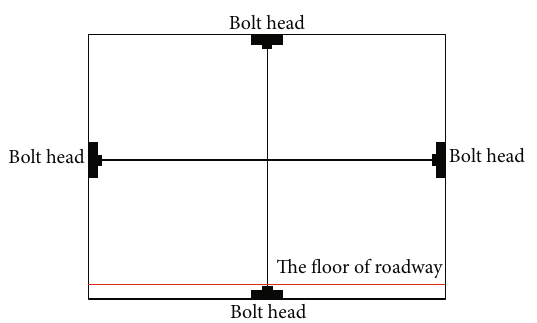
Figure 12: Full section monitoring points of haulage gateway.